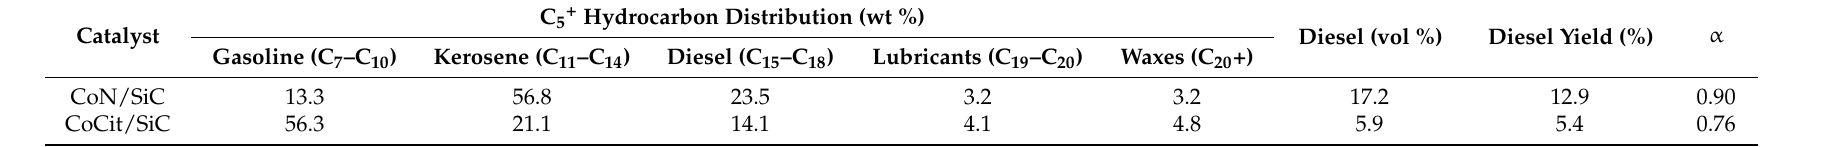
Table 3. C 5+ hydrocarbon distribution: 20 bar; 250 ˝ C; 6000 Ncm 3 /g ¨ h; H 2 /CO: